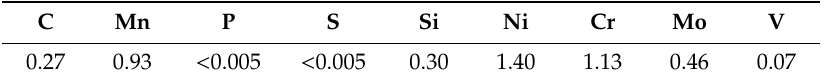
Table 1. Chemical composition (wt.%) of the rolled homogeneous armor (RHA) steel plates.